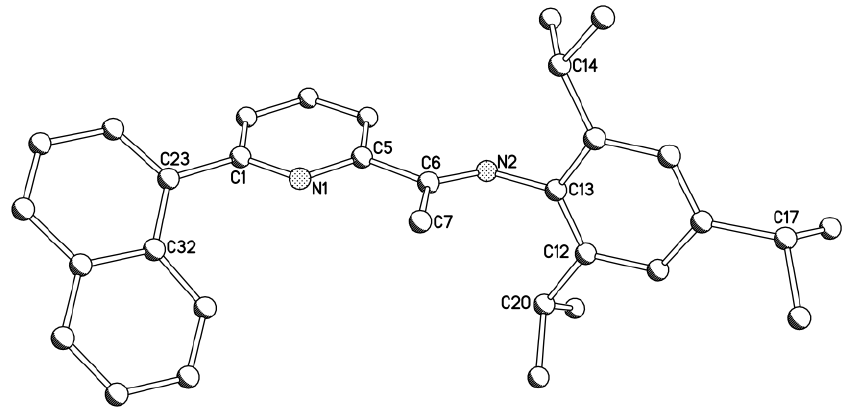
Figure 2. Molecular structure of L1 tripp with atom labeling scheme; all hydrogen atoms have been omitted for clarity. Table 1. Selected bond distances (Å) and angles (deg) for L1 dipp and L1 tripp . Bond Distances Compound